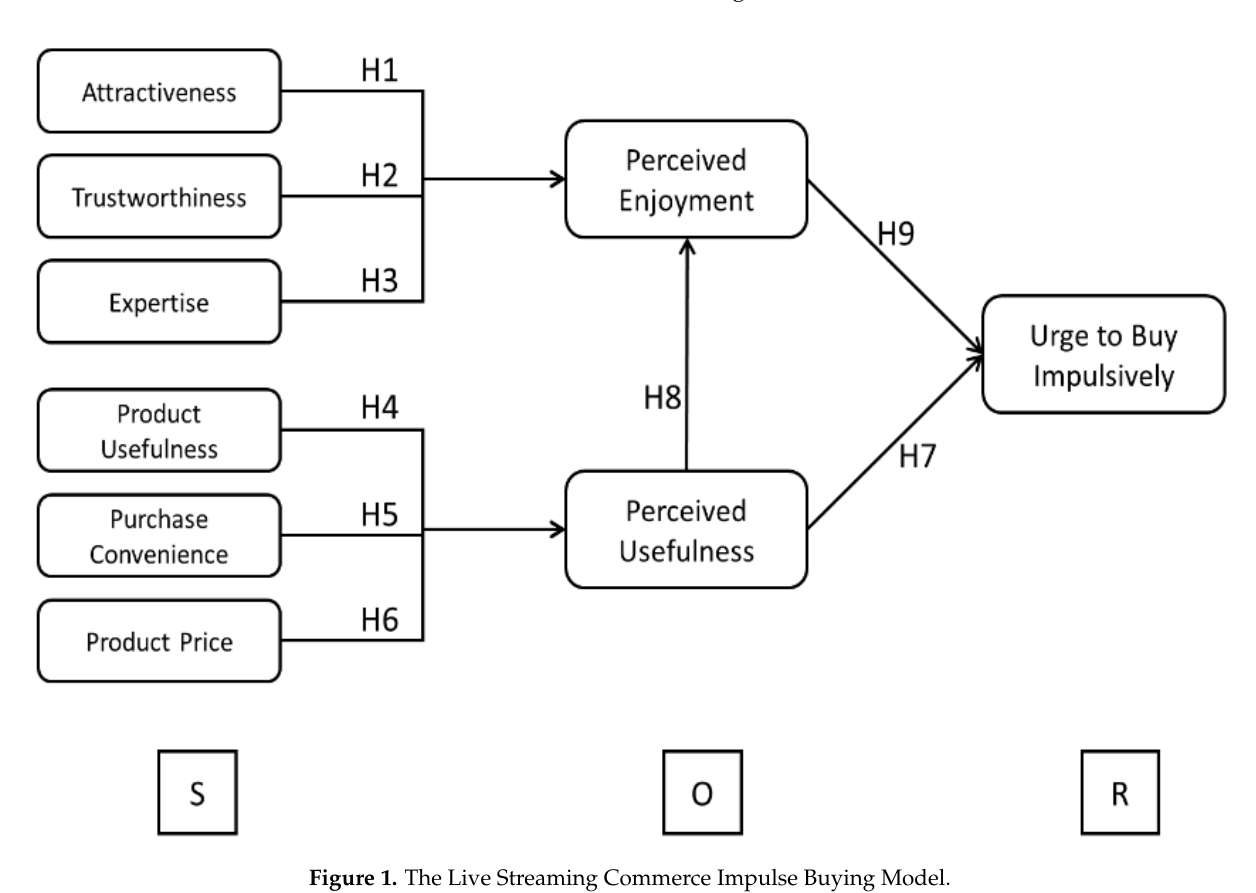
Figure 1. The Live Streaming Commerce Impulse Buying